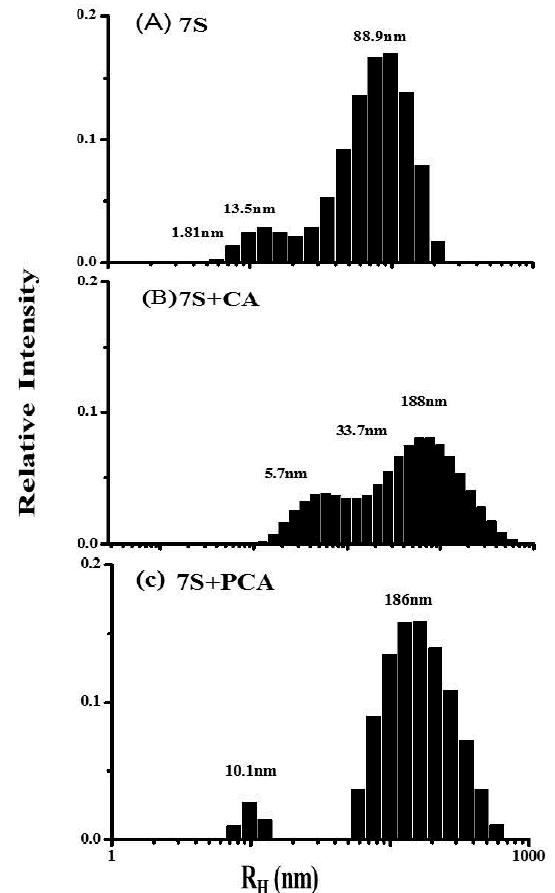
Figure 6. Relative scattered light intensity distribution curves for 0.5 µ M soy protein 7S ( A ); and 0.5 µ M soy protein 7S in the presence of 5 mM CA ( B ); or 5 mM PCA ( C ). Conditions: 100 mM MOPS (5 mM NaCl), pH 7.0, 25 °C.